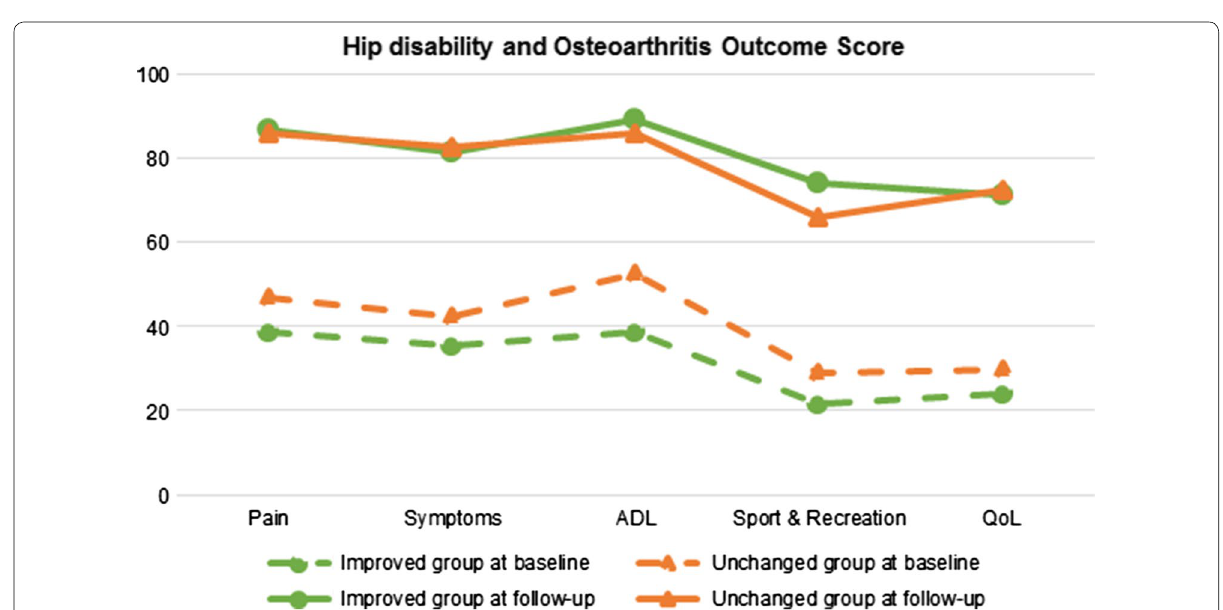
Fig. 3 Patient-reported function and pain, evaluated using the Hip disability and Osteoarthritis Outcome Score, at baseline and 1-year follow-up after total hip arthroplasty in ( n 34) patients with hip osteoarthritis. Patients grouped by postoperative change in performance-based function. = ADL, activities of daily living; QoL, hip-related quality of